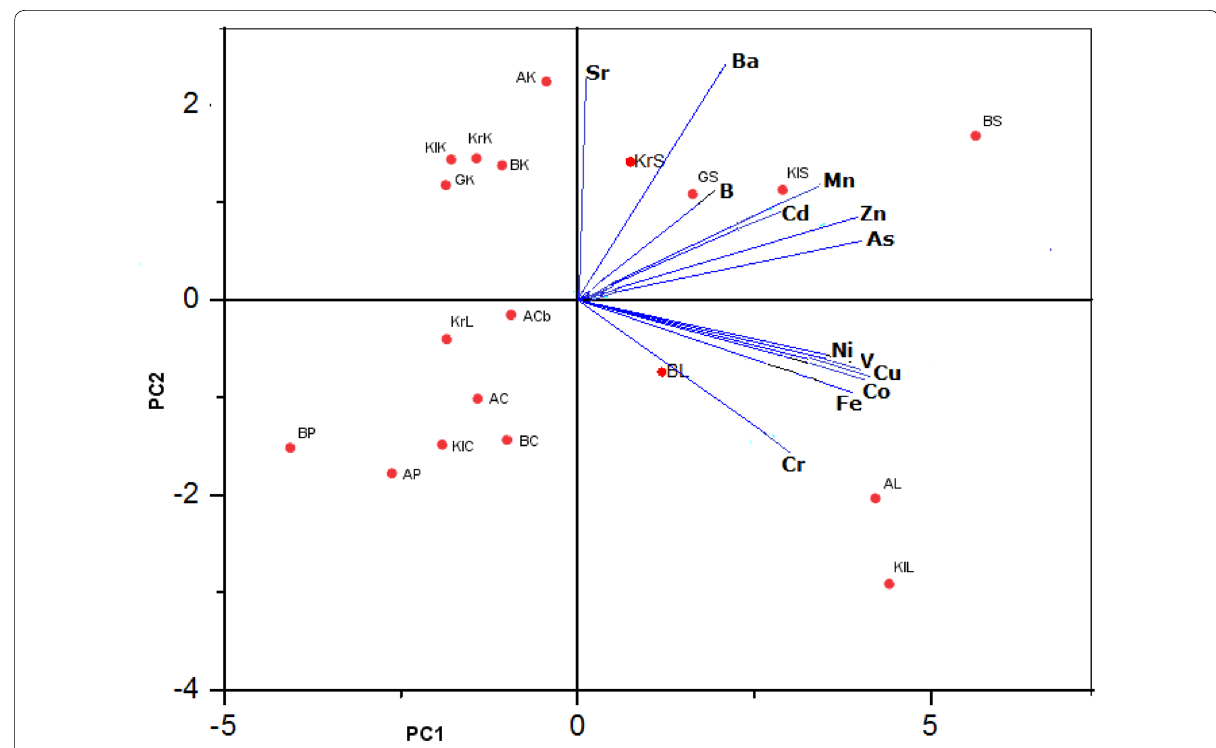
Fig. 2 Biplot of scores and loadings matrices for the first two PCs of vegetables. Where BK Burayu Ethiopian kale, KlK Kolfea Ethiopian kale, KrK Kera Ethiopian Kale, GK Gofa Ethiopian kale, BL Burayu Lettuce, KlL Kolfea Lettuce, KrL Kera Lettuce, AL Akaki Lettuce, ACb Akaki Cabbage, BS Burayu Swiss chard, KlS Kolfea Swiss chard, KrS Kera Swiss chard, GS Gofa Swiss chard, BC Burayu Carrot, KlC Kolfea Carrot, AC Akaki Carrot, BP Burayu potato and AP Akaki